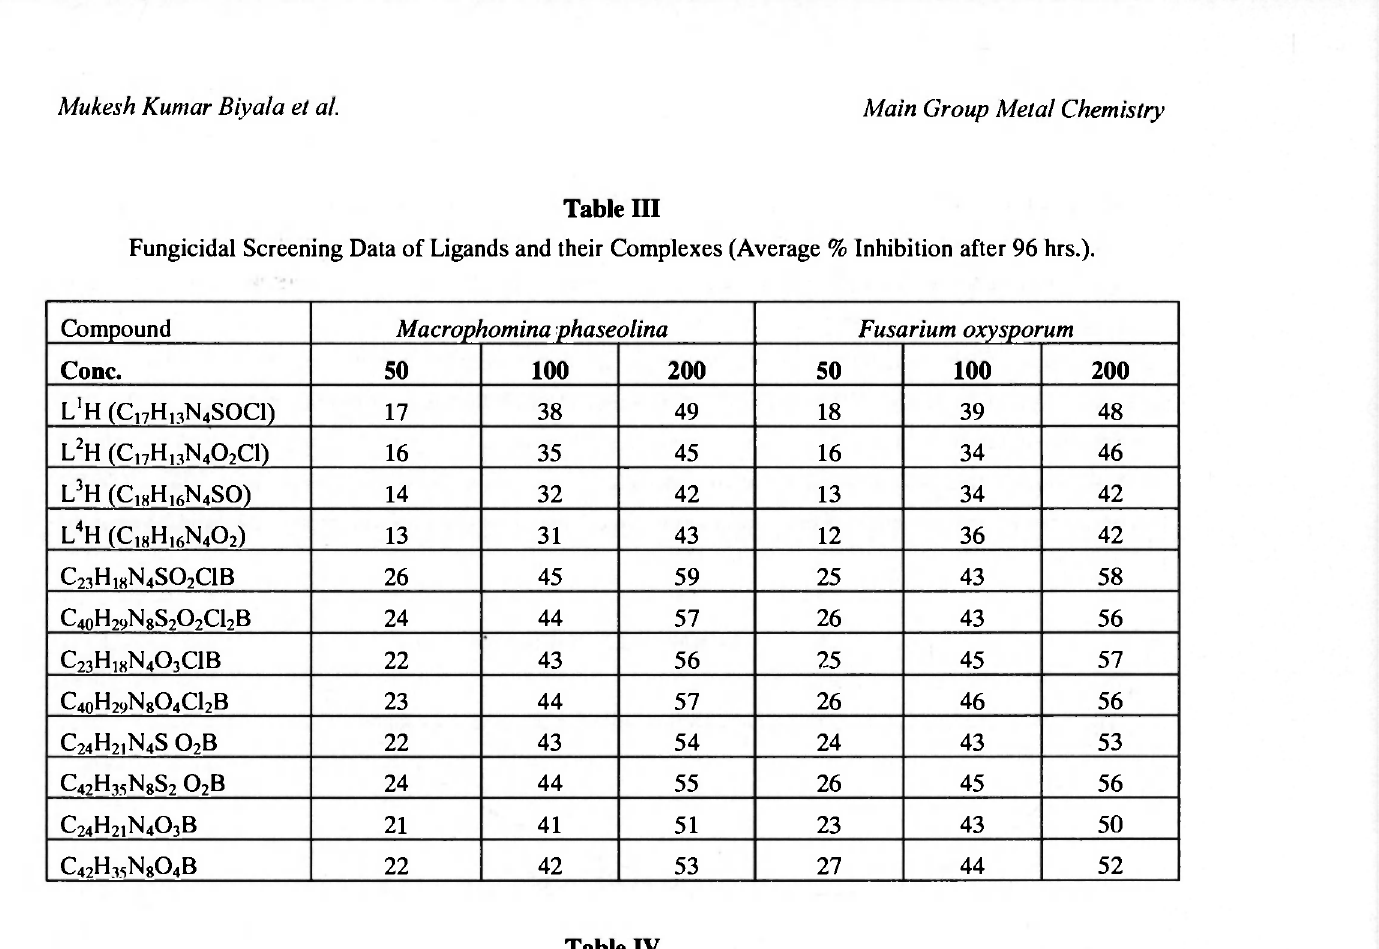
Antibacterial Activity of Ligands and their Complexes (Diameter of Inhibition Zone after 30hrs. (mm)) Compound Klebsiella aerogenous (-)